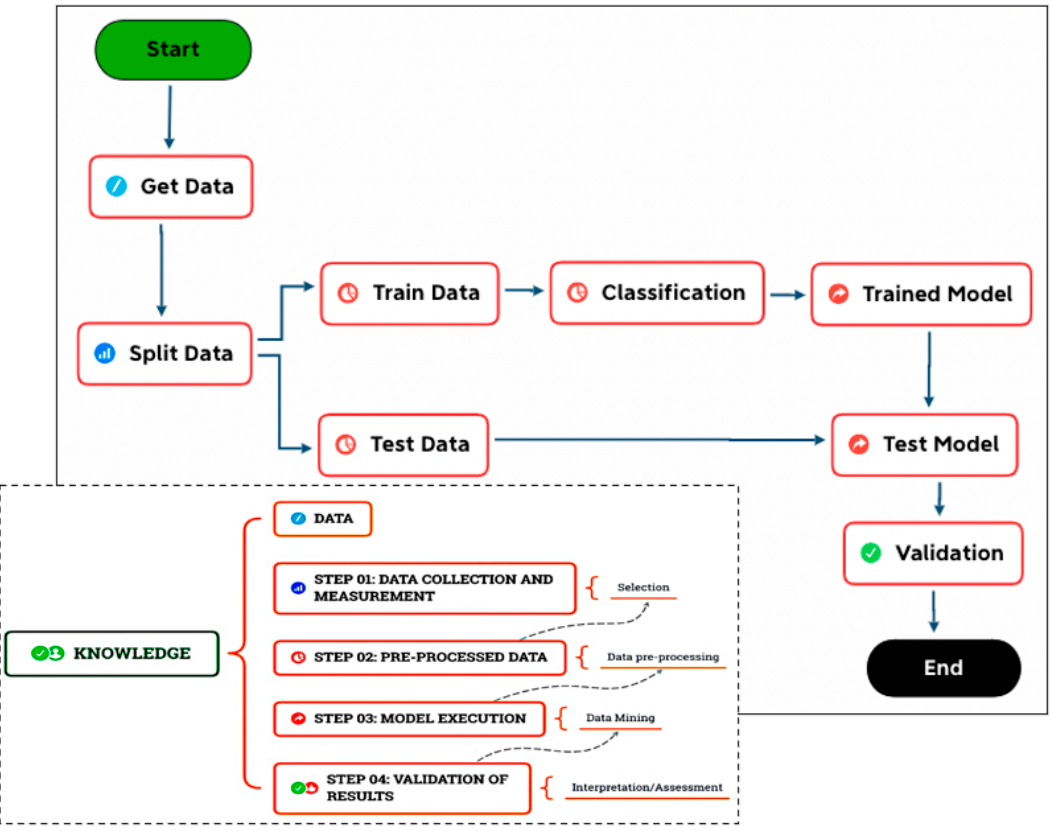
Figure 2. Get knowledge cycle.